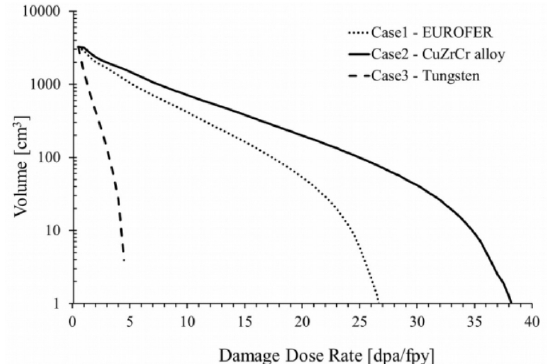
Figure 26. Damage dose rate as a function of HFTM volume with the 3 materials to be studied in DONES. Reprinted with permission from Ref. [131]. Credit c (cid:13) IOP Science,